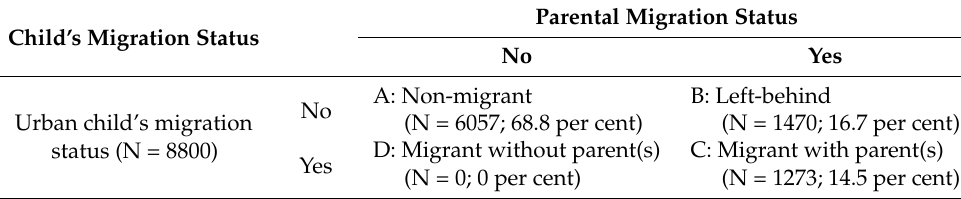
Table 1. Typology of urban children: CEPS 2014. Child’s Migration